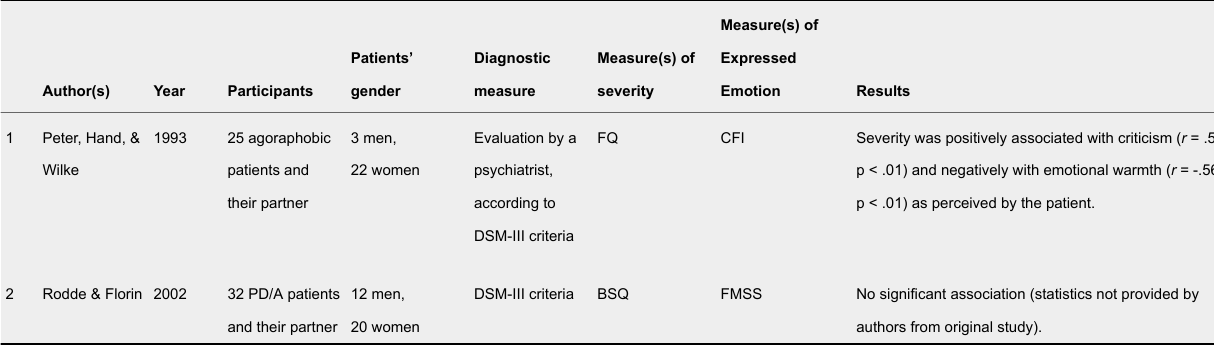
Description of Studies Examining the Association Between Expressed Emotion and